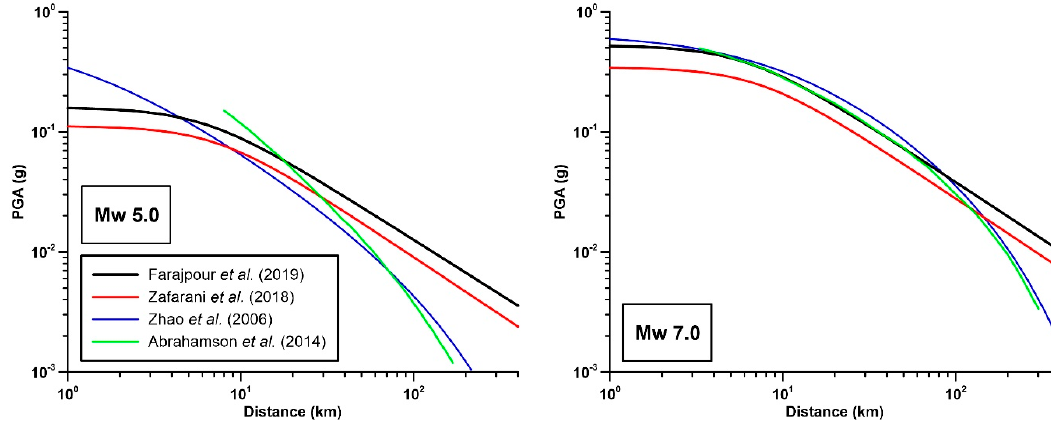
Figure 4. Ground-motion attenuation models considered in the current assessment (for magnitudes Mw 5.0 and 7.0), for the B/C NEHRP boundary site class. Mw 5.0 and 7.0), for the B / C NEHRP boundary site